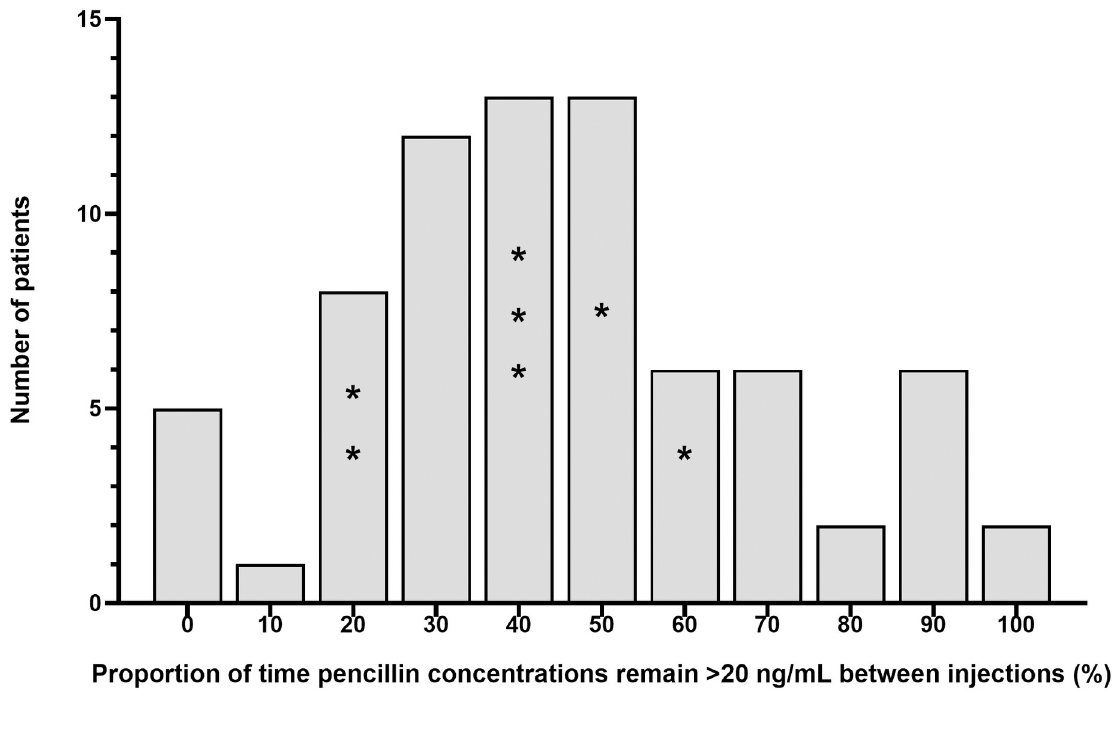
PLOS NeglectedTropical Diseases | https://doi.org/10.1371/journal.pntd.0009399 June 11, 2021 9 /